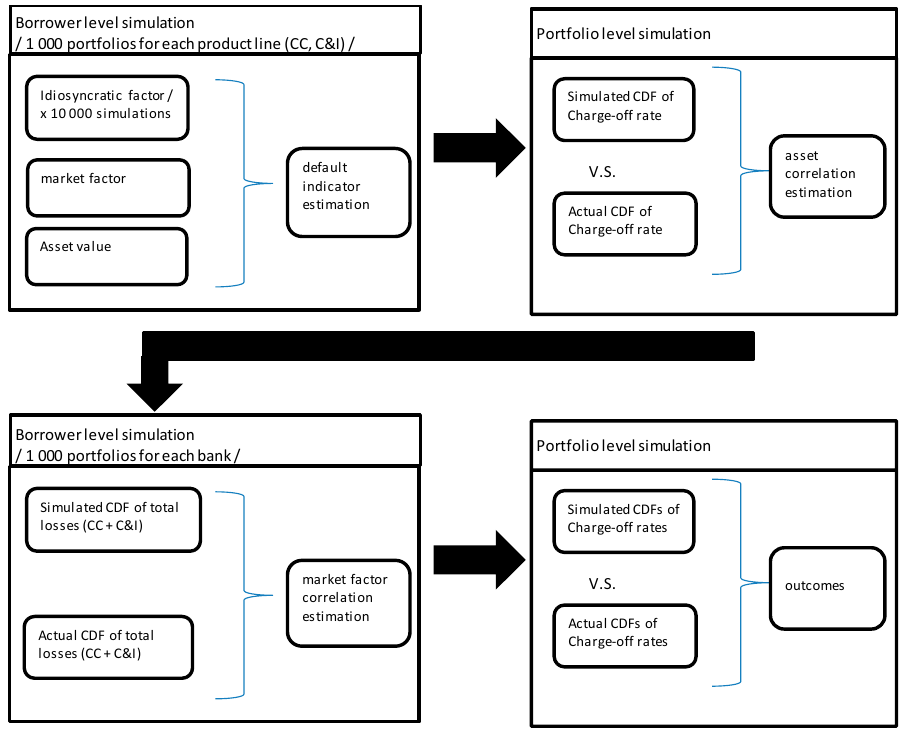
Figure 8. Simulation procedure scheme.